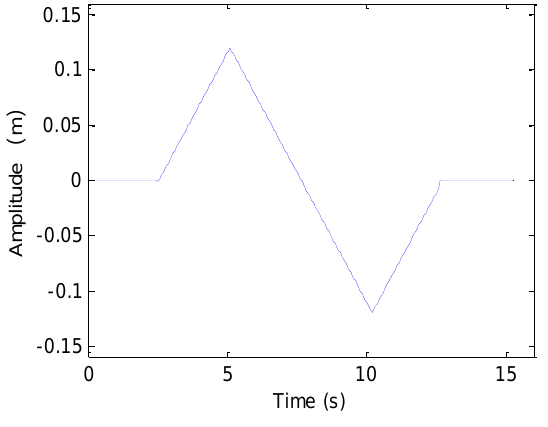
Figure 5. Sawtooth perturbation.